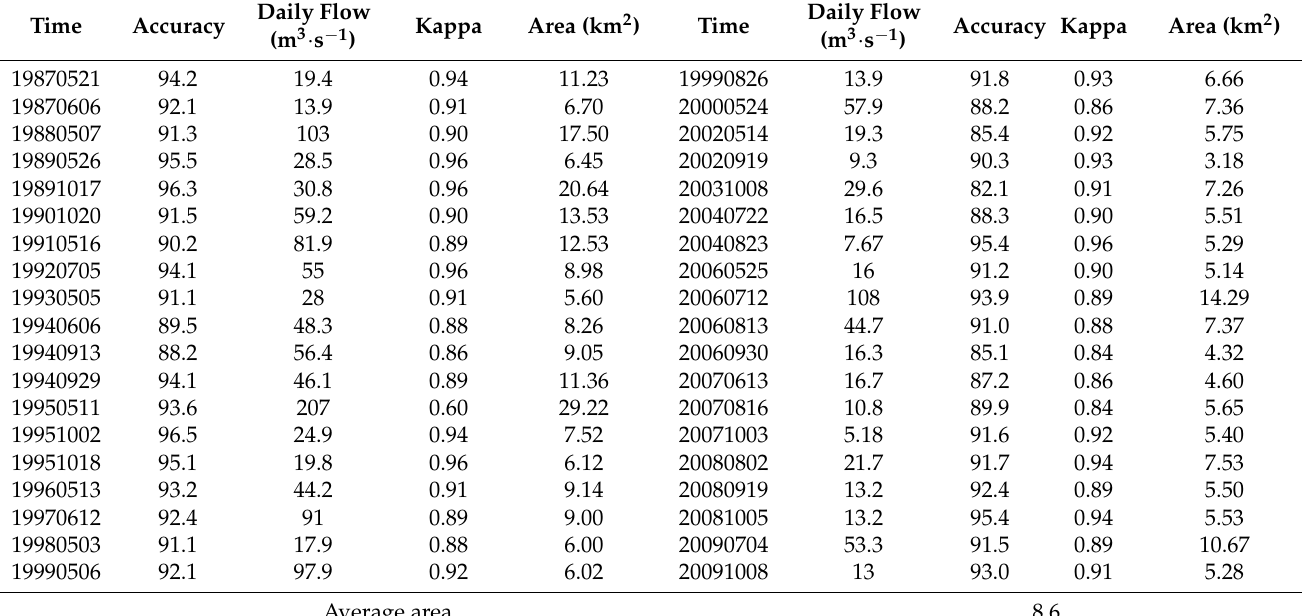
Table 2. Verification of the accuracy of the MNDWI, Kappa coefficient, and water-inundation area in 38 periods before dam construction [25].